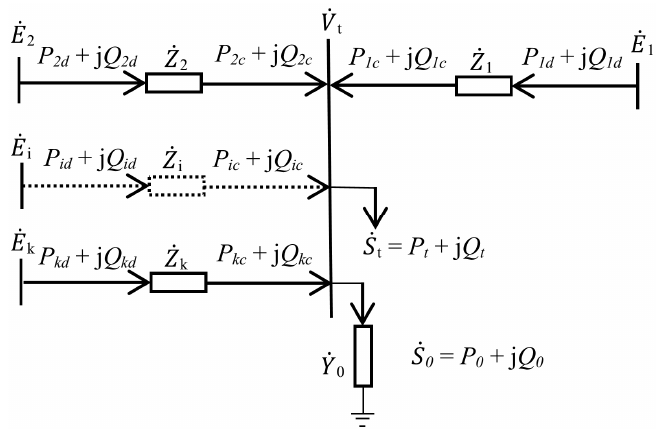
Figure 2. Simplified equivalent diagram.